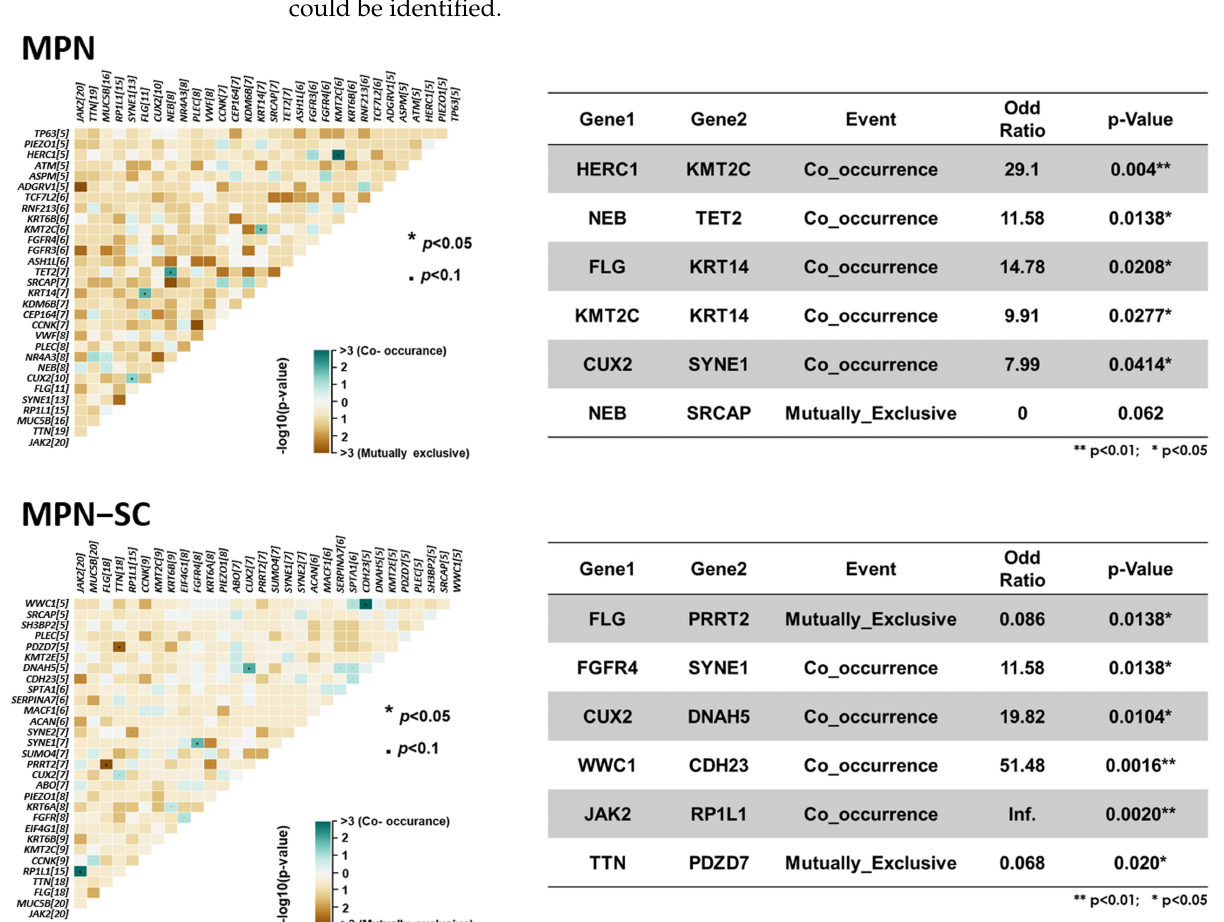
Figure 3. Patterns of co-occurrence and mutual exclusiveness of genes with variants between the two groups of MPN patients. Co-occurring and mutually exclusive gene pairs are highlighted in dark green and brown colors, respectively. Several interacting paired variants with statistical significance are outlined in the accompanying tables. Upper panel: MPN control group. Lower panel: MPN–SC